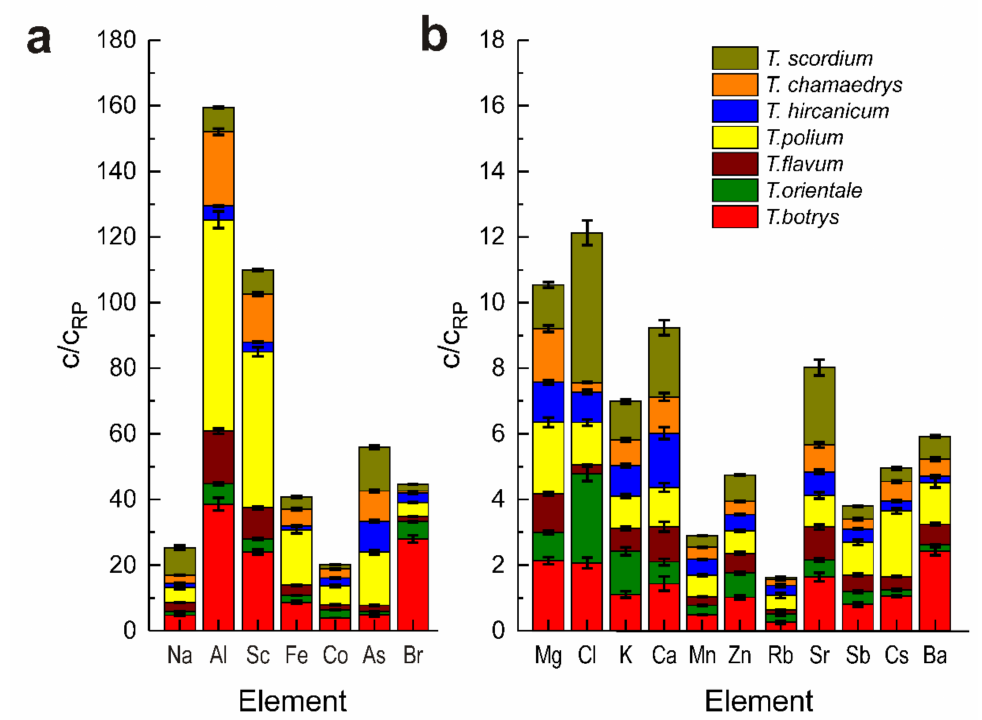
Figure 1. The stacked bar chart illustrates the distribution of mass fractions of all 18 elements determined in all analyzed plants; each taxon is normalized to the reference plant [39,40]: ( a ) elements with C/C RP > 20; ( b ) elements with C/C RP <